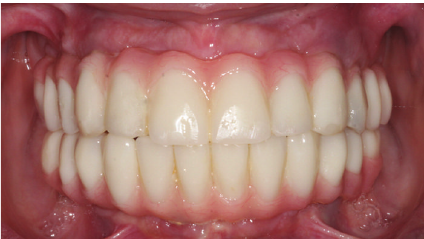
Figure 9: Intraoral photograph shows screw-retained implant pro- visional prostheses. Pink acrylic was added to enhance esthetics, which will be used as “blue-print” for the definitive prostheses.